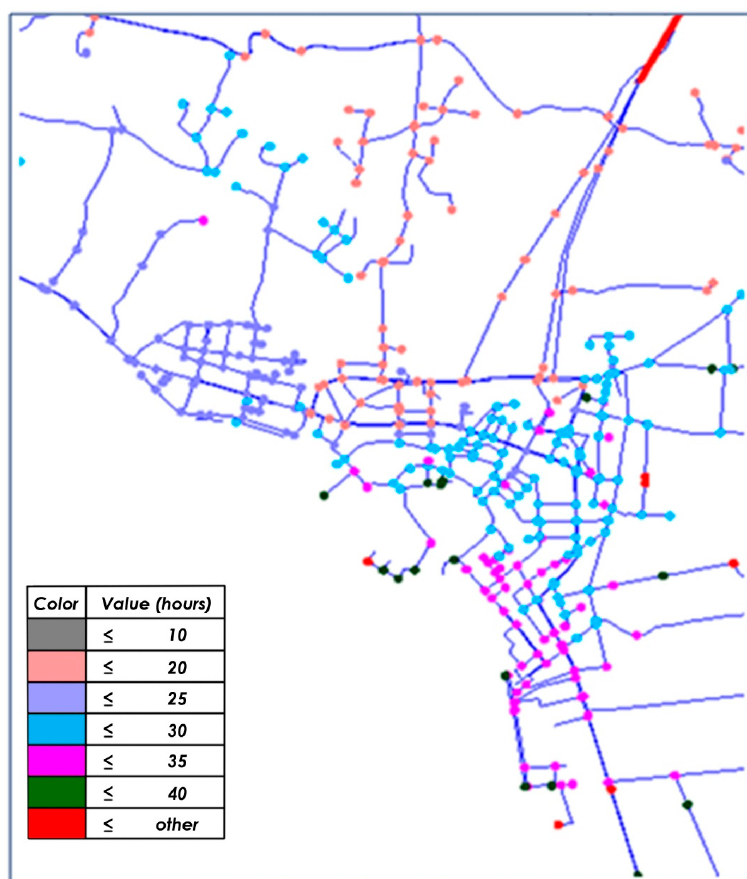
Figure 10. Nodal water age after 48 hours of analysis.